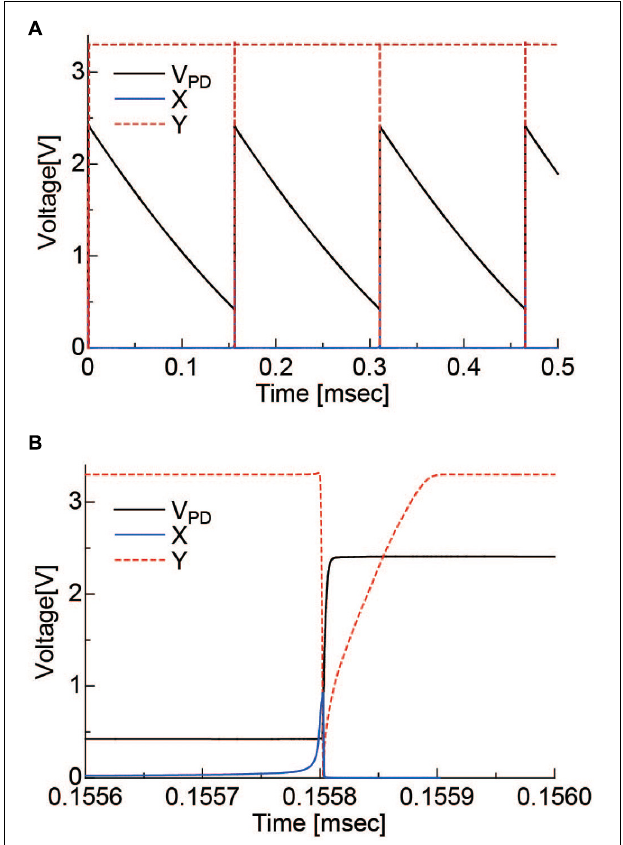
FIGURE 4 | (A) Simulation results of the self-resetting pixel. (B) is the magnified plot of the self-resetting region. X, Y correspond to the nodes indicated in Figure 2